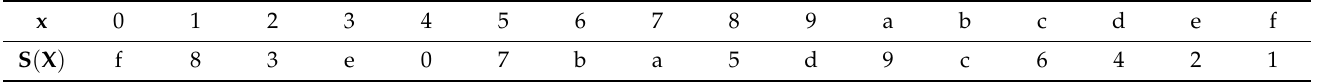
Table 1. A Sbox_Nibble Layer of our scheme.